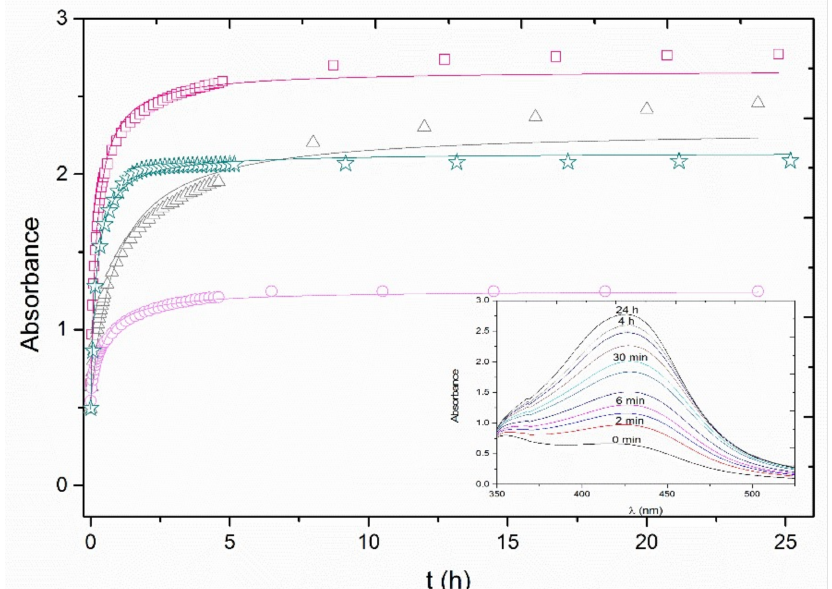
Figure 2. Absorption kinetics of the silver NPs’ growth with four different extracts: white thyme (squares), eucalyptus (triangles), oak (stars), and white cedar (circles). Inset shows the evolution of the white thyme absorption spectrum with time. Data were fitted to a second order